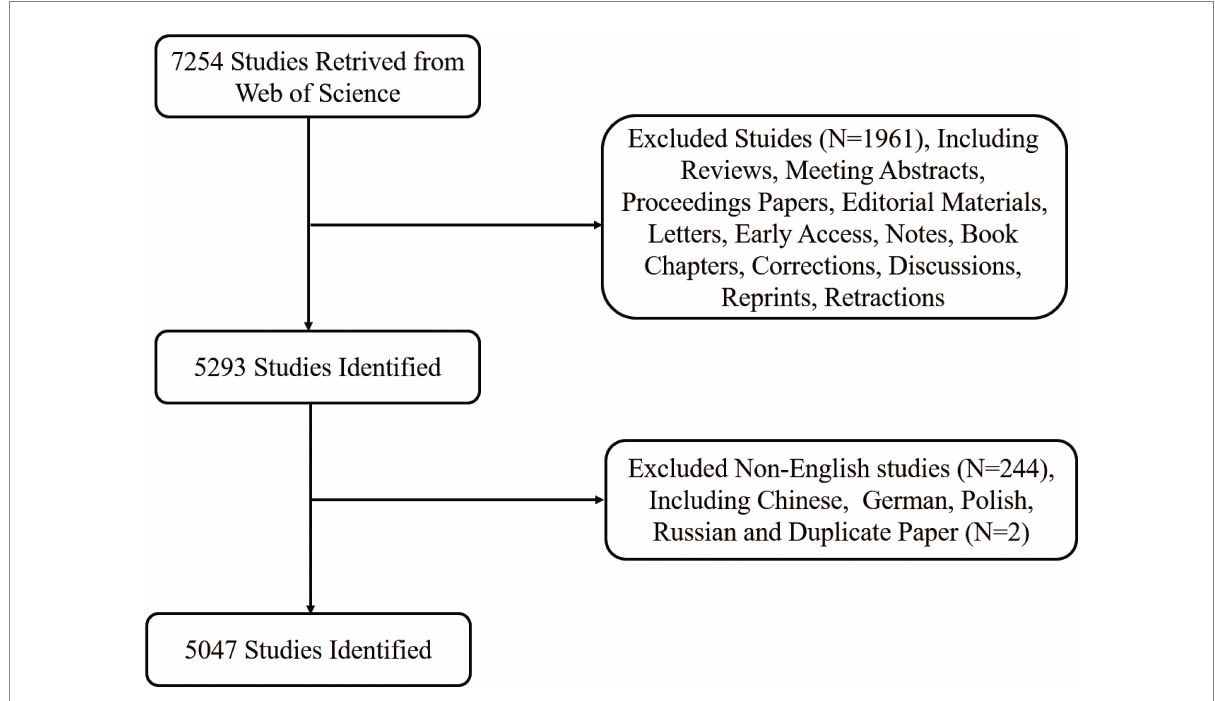
FIGURE 1 Flowchart of literature